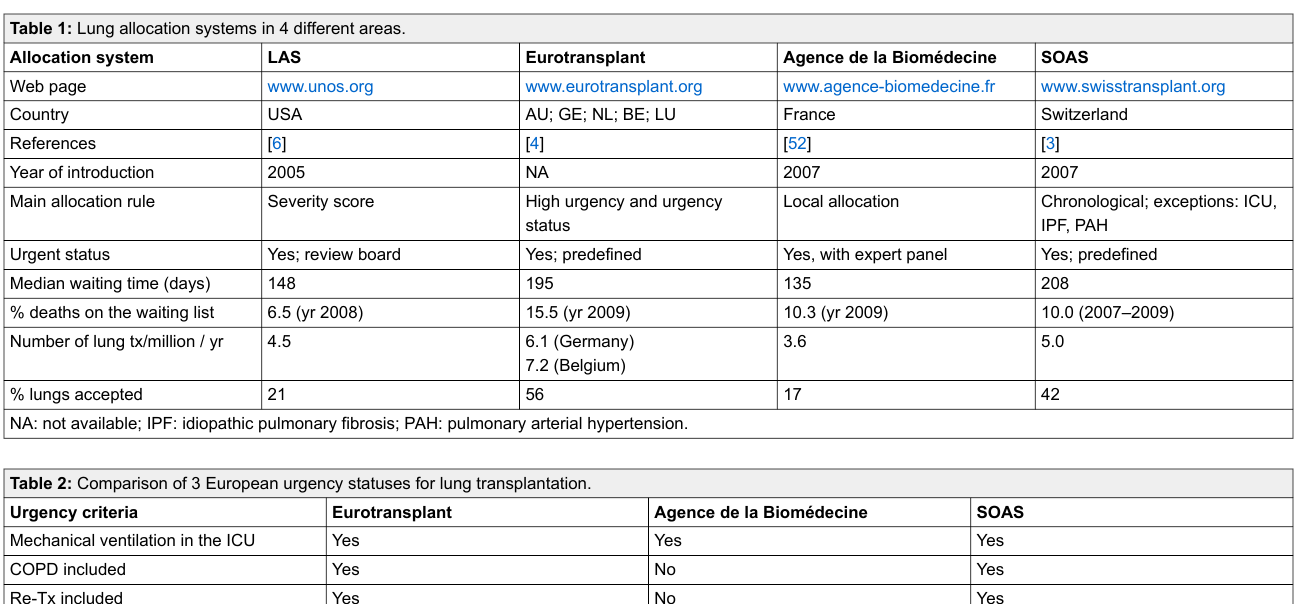
Table 1: Lung allocation systems in 4 different areas. Allocation system